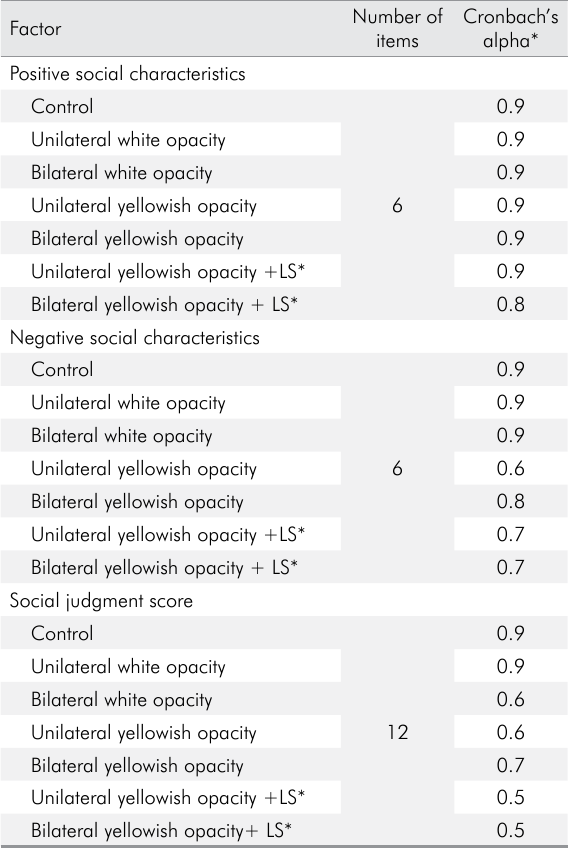
Table 3. Internal consistency measures of the social judgment scale in